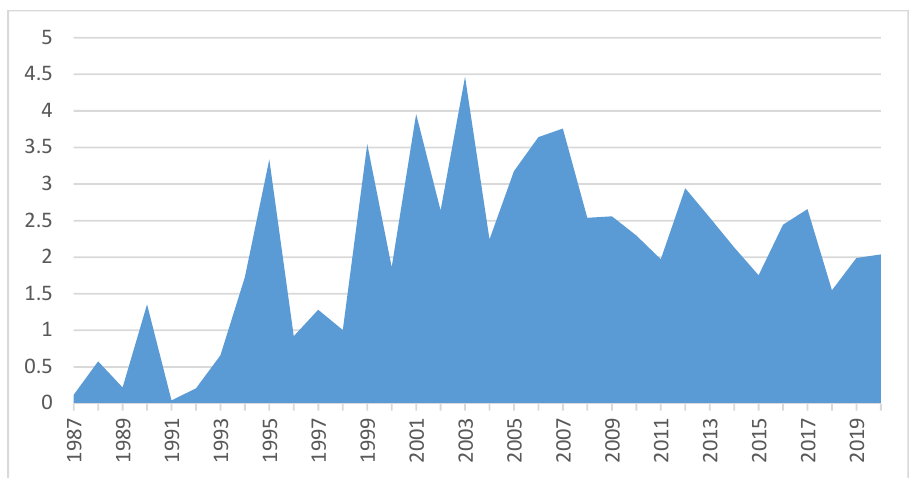
Figure 2. Average of citations per year.